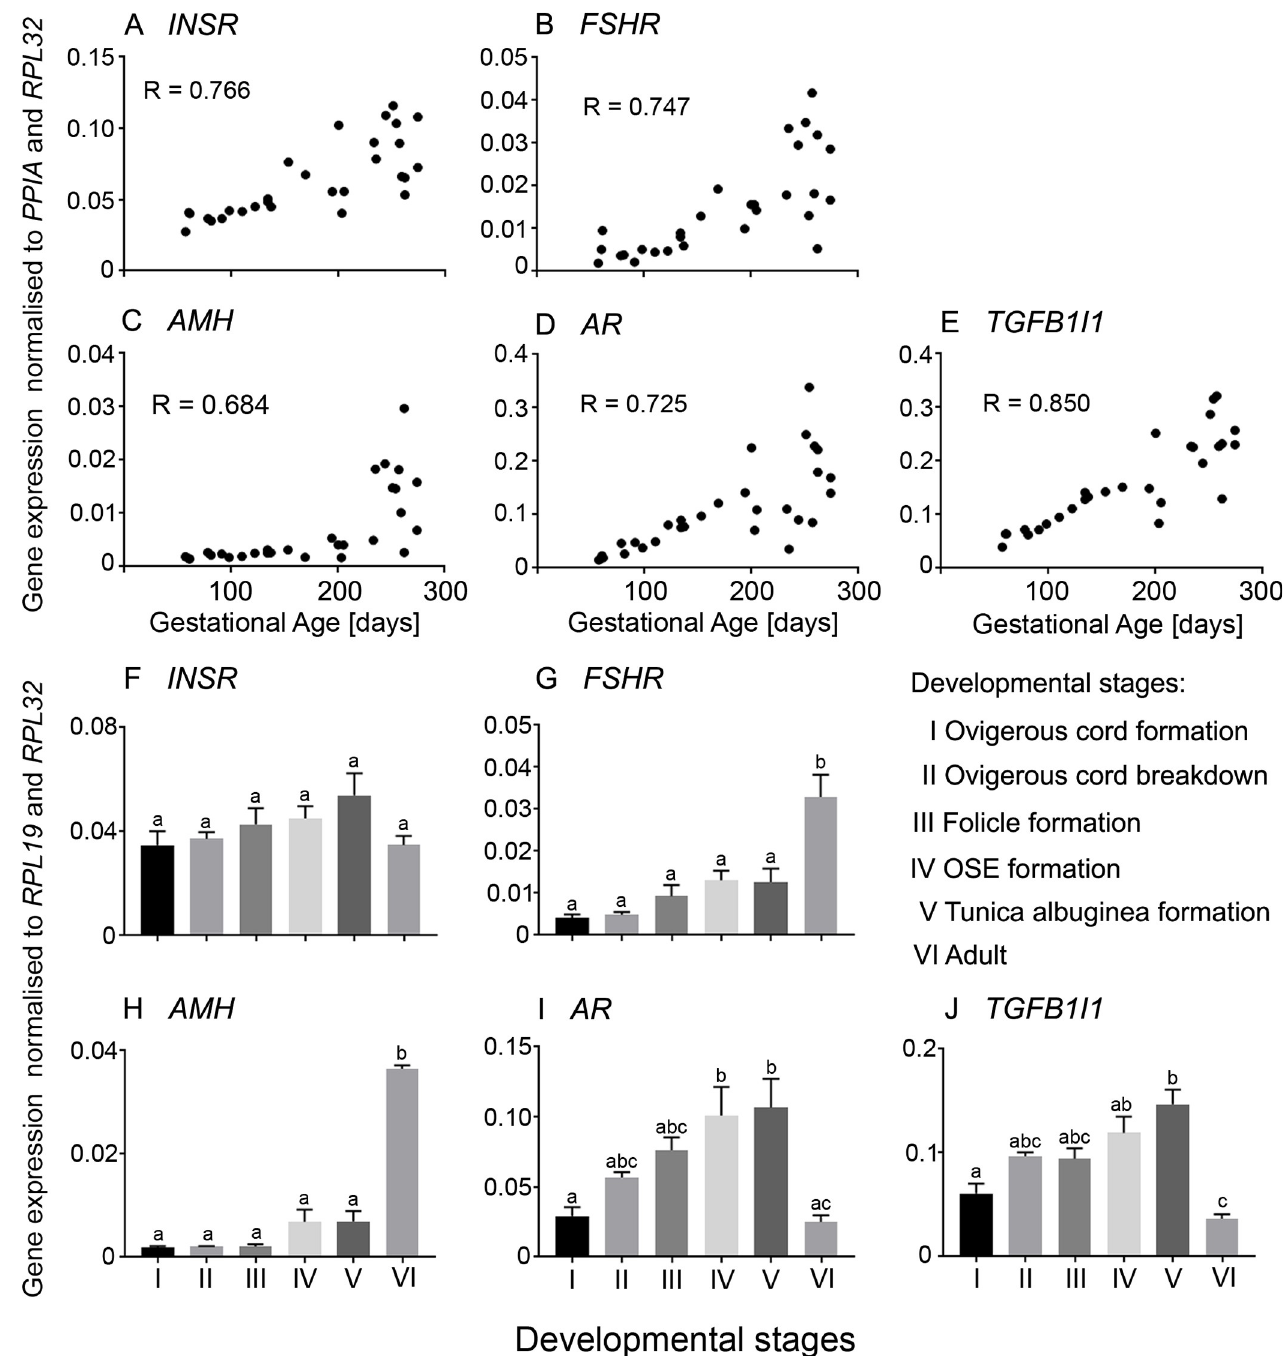
Fig 3. A-E . Scatter plots of mRNA expression levels from genes which are highly expressed late in gestation in bovine fetal ovaries (n = 27). Pearson correlation coefficient (R) test was used to analyse data and P values are shown in Table 2. F-J . Differential mRNA expression levels in ovaries grouped into six stages of ovarian development based on their histological morphology: ovigerous cord formation (n = 7, Stage I), ovigerous cord breakdown (n = 4, Stage II), follicle formation (n = 3, Stage III), surface epithelium formation (n = 8, Stage IV), tunica albuginea formation (n = 5, Stage V) and adult (n = 6, Stage VI). Data are presented as mean ± s.e.m. (normalised to PPIA and RPL32 for scatter plot and RPL19 and RPL32 for bar graphs). One-way ANOVA with post hoc Holm- Sidak test were used to analyse the data. Bars with different letters are statistically significantly different from each other (P < 0.05).